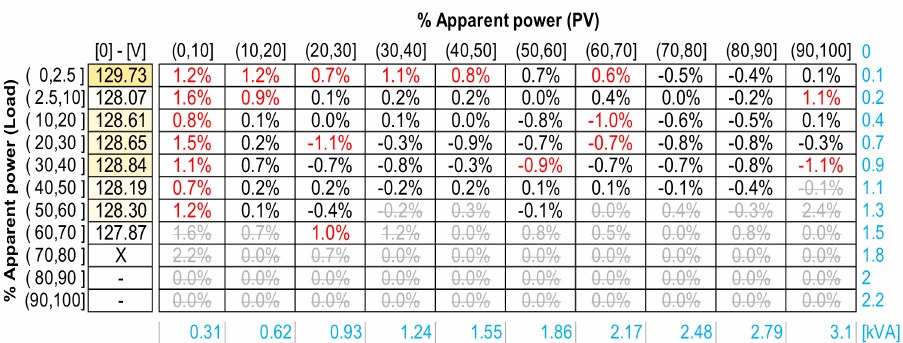
Figure 17. Matrix of Vrms for PVS Of f scenarios and variations of Vrms for PVS On of Phase